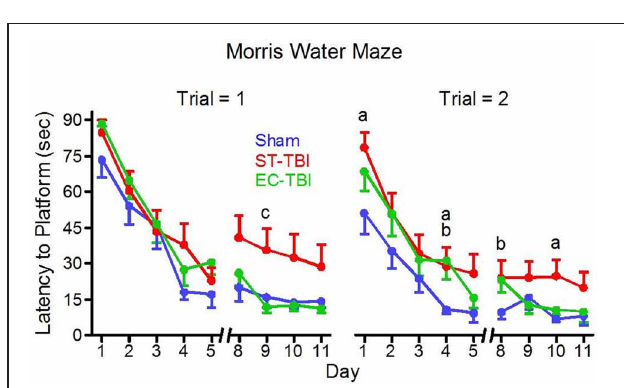
FIGURE 5 | Reduced deficits on the morris water maze task associated with enrichment before injury. EC-TBI and Sham animals reached the hidden platform significantly faster than ST-TBI animals in trial 1 following 2 day break for memory retention. a p < 0 . 05 Sham vs. ST-TBI, b p < 0 . 05 Sham vs. EC-TBI, c p < 0 . 05 ST-TBI vs. EC-TBI using two-tailed 2-sample t